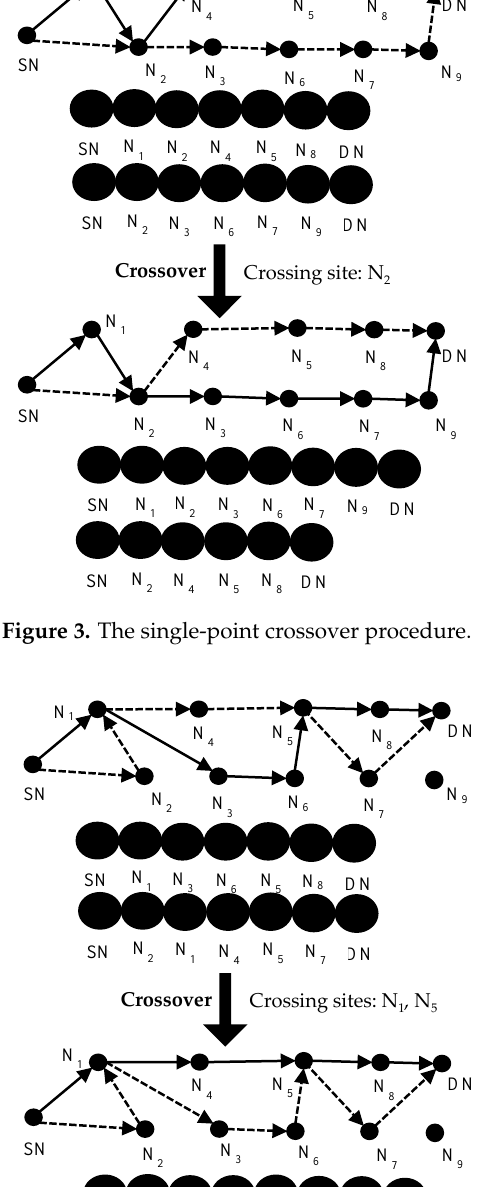
N and N . After crossover operation, the produced 3 5